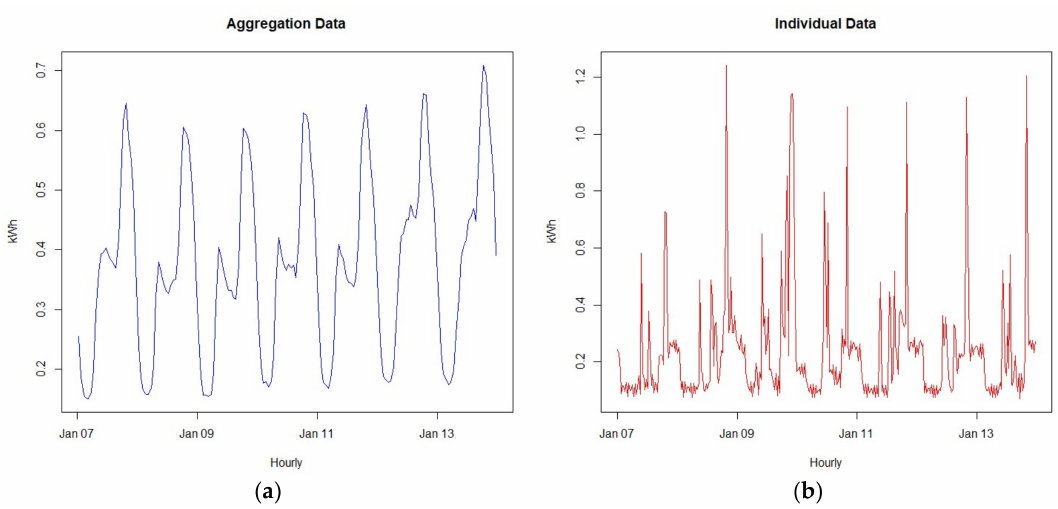
Figure 1. Visualization of the aggregation and individual data from a smart